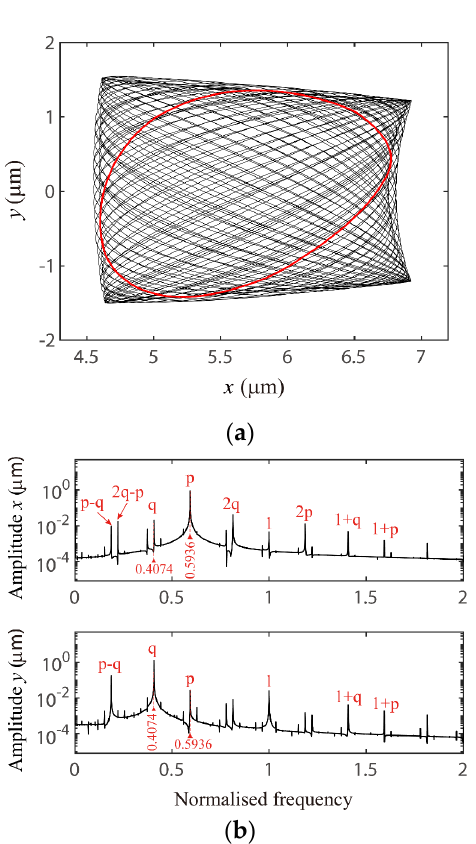
Figure 7. For δ 0 = 1.5 μ m, VC quasi-period response characteristics, ( a ) orbit (black line) and its Poincare mapping (red dots), ( b ) frequency spectrum when Ω = 400 rad/s. Table 4. Period-1 motion Floquet multipliers λ m around B 7 .